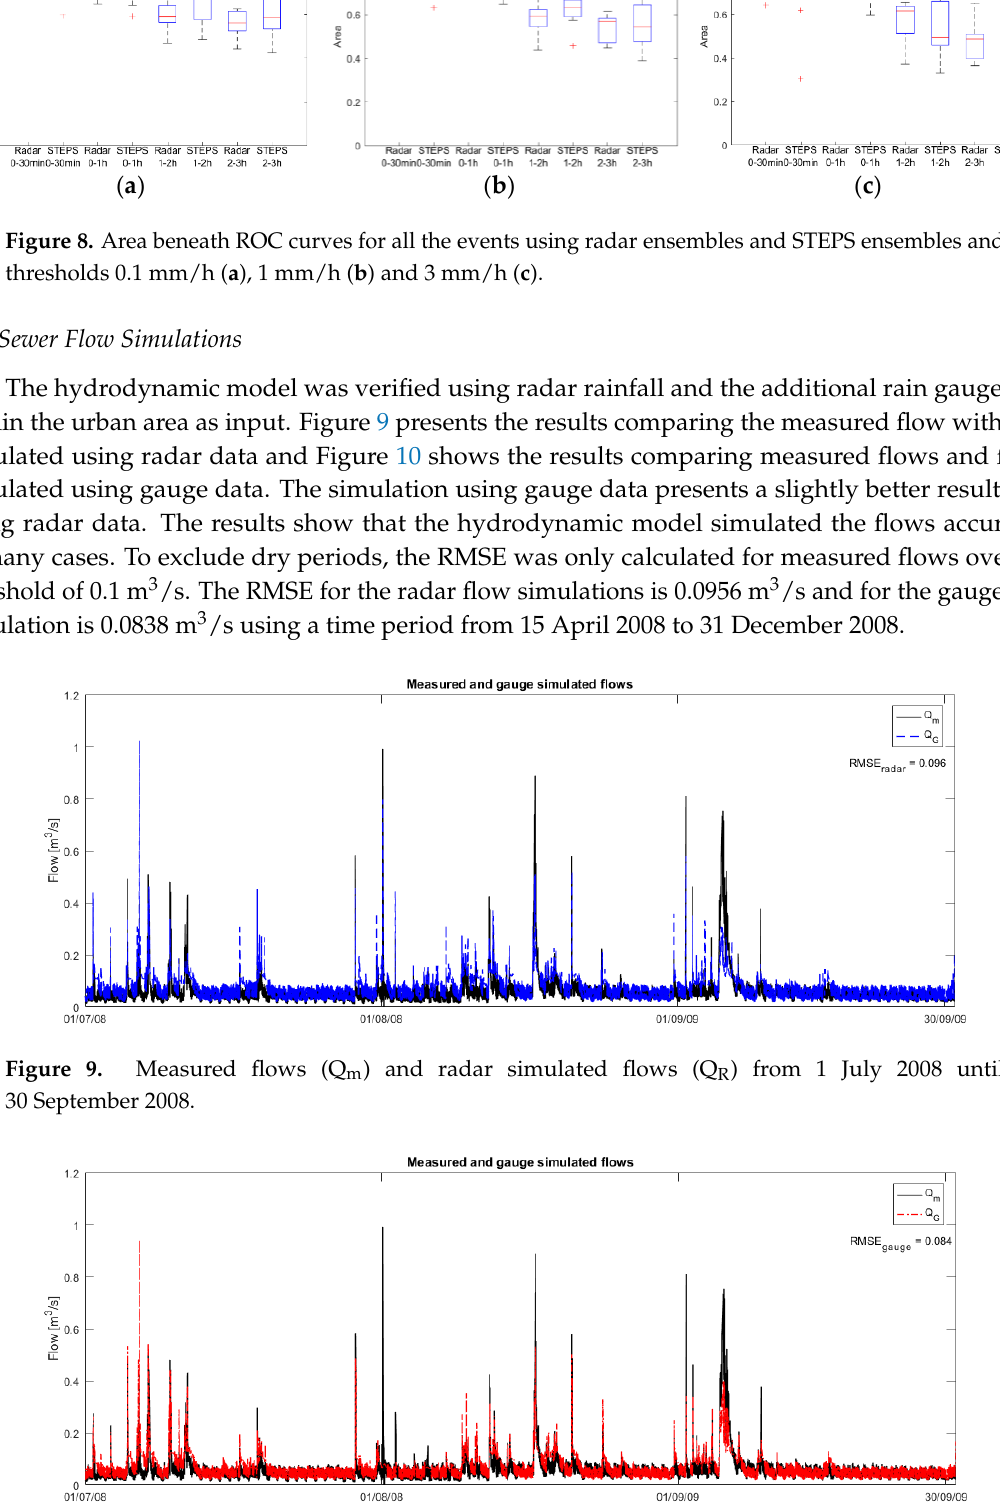
Figure 7. ROC curves for radar and STEPS ensembles for event on 14 October 2008 starting at 15:00 for Radar ensembles and rainfall thresholds (th) equal to 0.1 mm/h ( a ), 1.0 mm/h ( b ) and 3.0 mm/h ( c ). and STEPS ensembles and thresholds equal to 0.1 mm/h ( d ), 1.0 mm/h ( e ) and 3.0 mm/h ( f ).